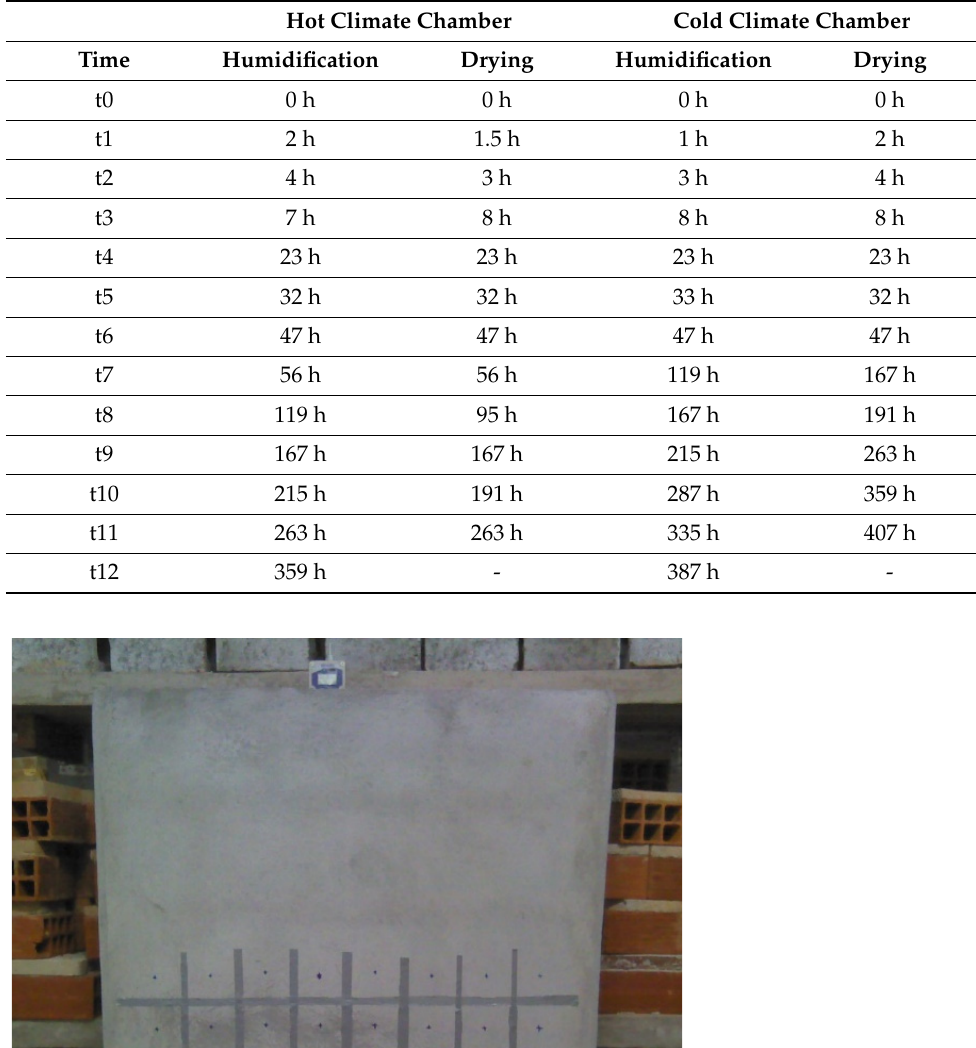
Table 5. Timeline for the measurements for each test.